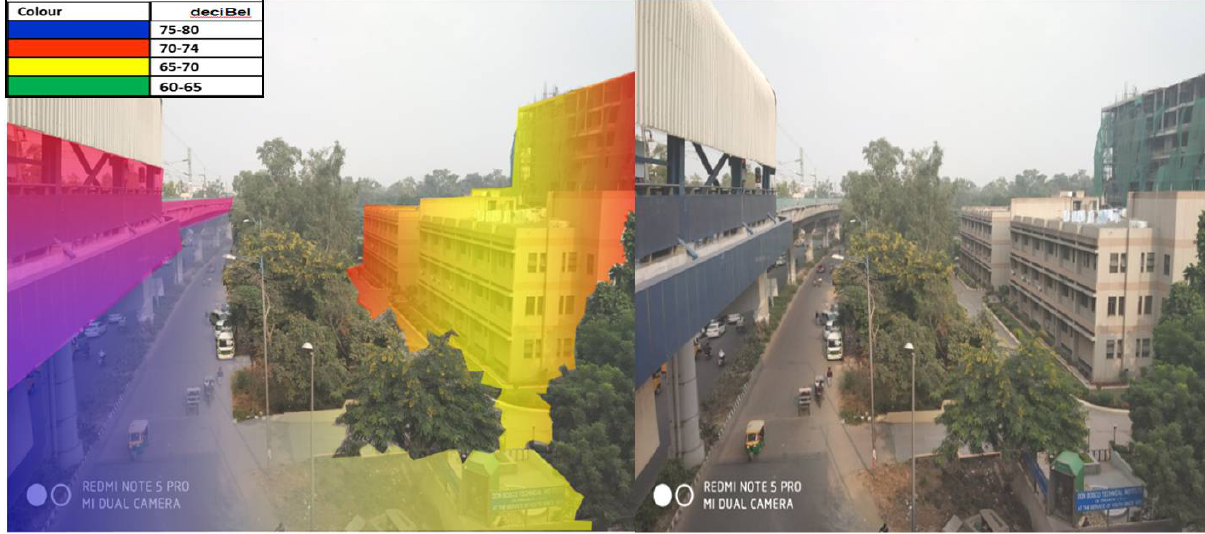
Figure 8: 3D noise mapping of Don Bosco Technical Institute area before installation of noise barrier